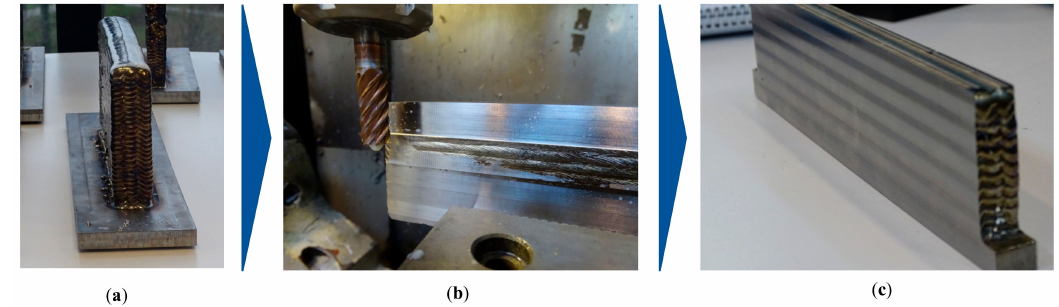
Figure 3. Additively manufactured part sample after the deposition process ( a ). Milling operation ( b ), part sample after milling process ( c